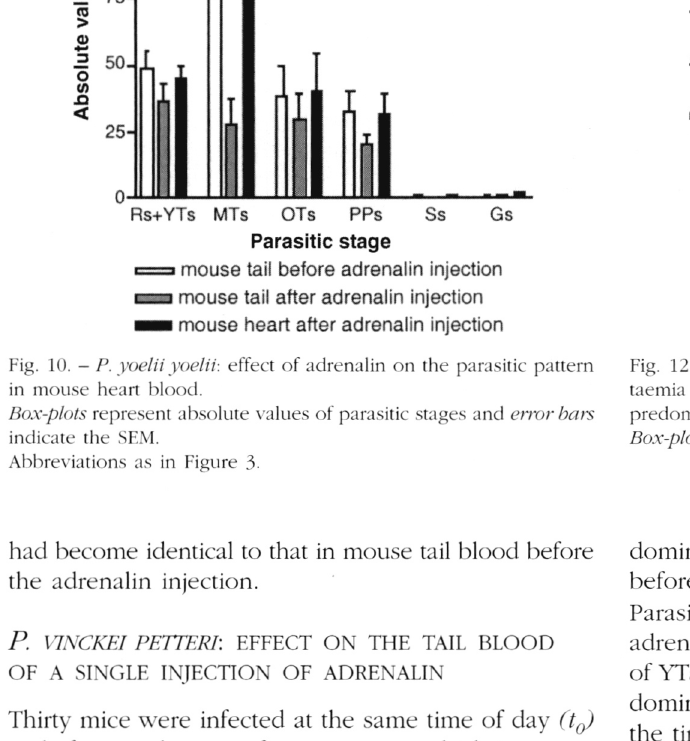
Fig. 9- - P. yoeliiyoelii. effect of adrenalin injection on mouse heart blood parasitaemia. Box-plots represent parasitaemias and error bars indicate the SEM.